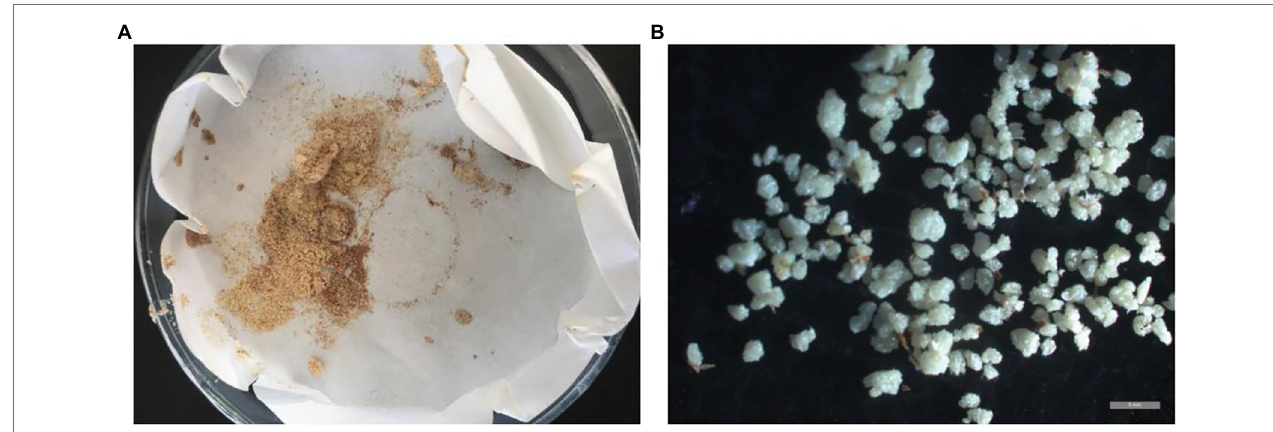
FIGURE 1 | The stone cells extracted from JT8. (A) The appearance of stone cells. (B) The microscopic morphology of stone cells. The gray bar represents 1 mm.